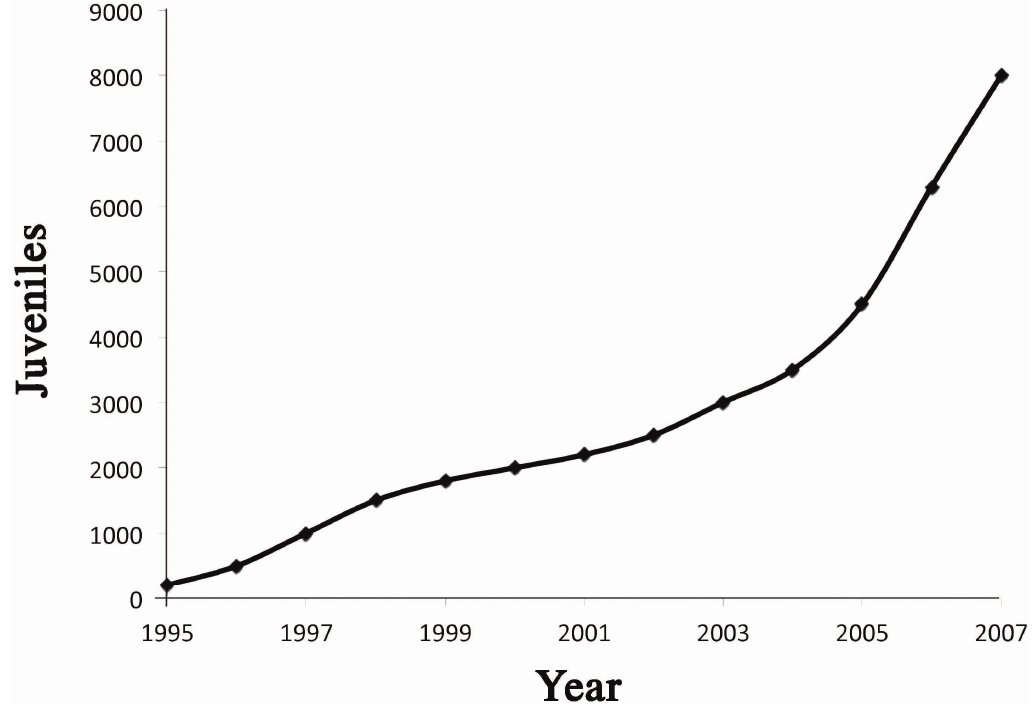
Figure 2. Cumulative stocking in the Narcea River until the year 2008, in thousands of